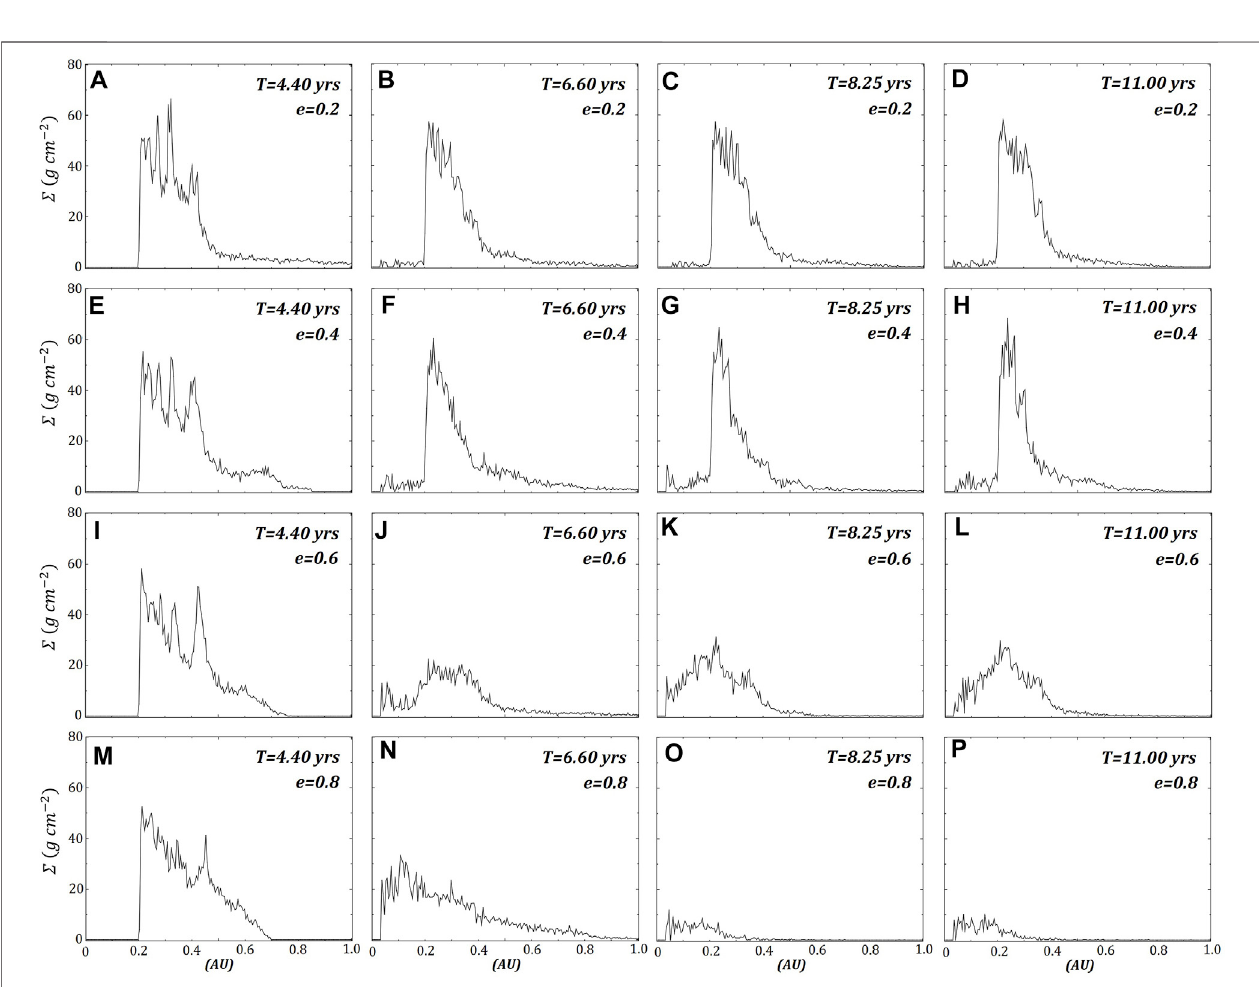
FIGURE 7 | The same four prograde ring models shown in Figure 1 with their azimuthally averaged surface densities. The rows represent each model, where e (cid:1) 0 . 2 (A – D) , e (cid:1) 0 . 4 (E – H) , e (cid:1) 0 . 6 (I – L) and e (cid:1) 0 . 8 (M – P) , while the column represents a snapshot in time at T (cid:1) 4 . 40 yrs ( A , E , I & M ) , T (cid:1) 6 . 60 yrs ( B , F , J & N ) , T (cid:1) 8 . 25 yrs ( C , G , K & O ) , T (cid:1) 11 . 00 yrs ( D , H , L & P ) , where all models began at apocentre.